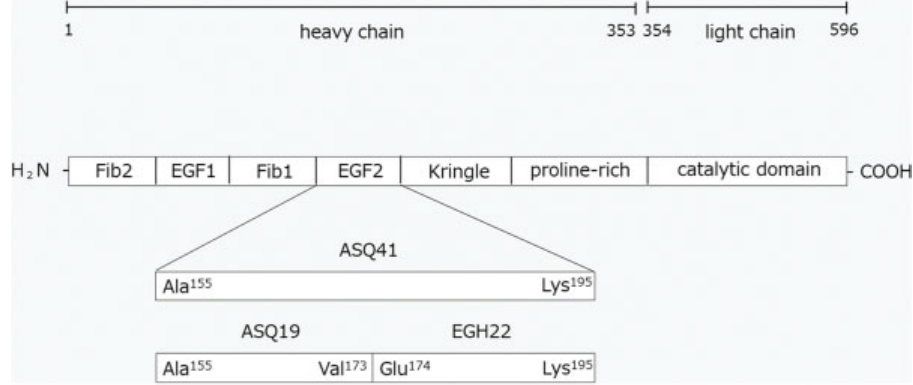
Fig. 1. Domain structure of factor XII (FXII). FXII consists of a fi bronectin type II domain (Fib2), an epidermal growth factor (EGF)-like domain (EGF1), a fi bronectin type I domain (Fib1), asecond EGF-like domain (EGF2), a kringle domain, a proline-rich region, anda catalytic domain. In the